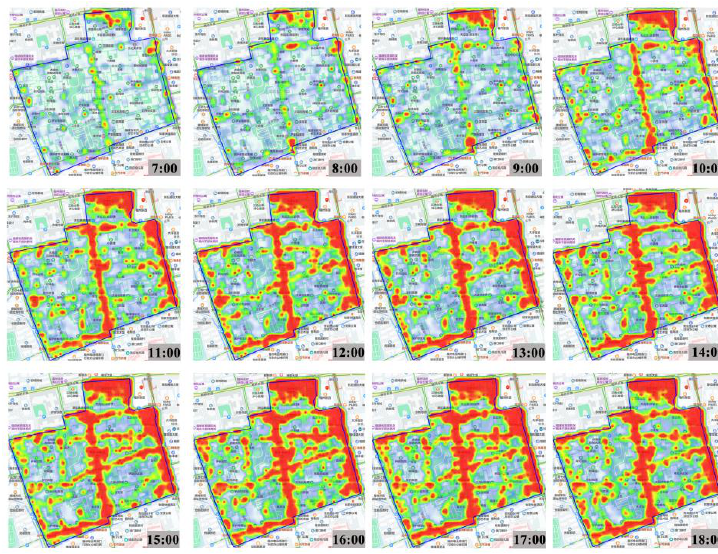
Figure 2. Map of heat value of tourist flow (part).